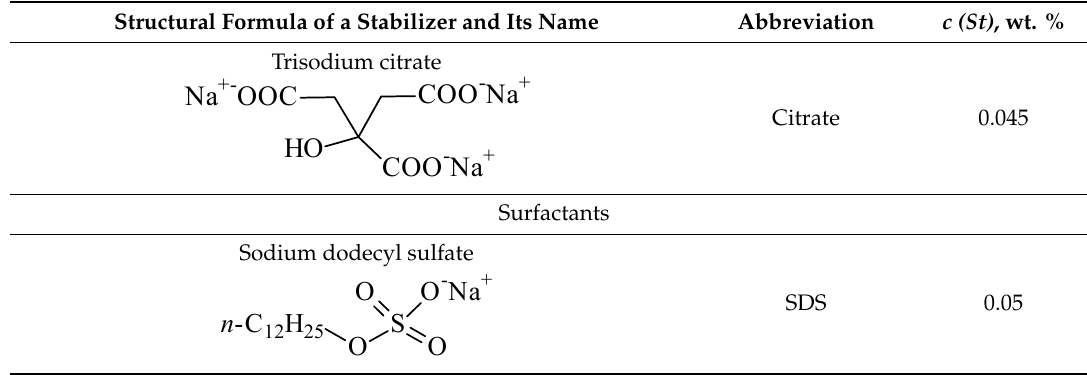
Table 1. The list of stabilizers of different chemical classes used for the synthesis of silver nanoparticles (NPs). Each aqueous dispersion contained 100 µg/mL of silver and the minimum Table1. Thelistofstabilizersofdifferentchemicalclassesusedforthesynthesisofsilvernanoparticles(NPs). amount of the capping agent c (St) needed to effectively stabilize silver Each aqueous dispersion contained 100 µ g / mL of silver and the minimum amount of the capping agent c (St) needed to effectively stabilize silver NPs.